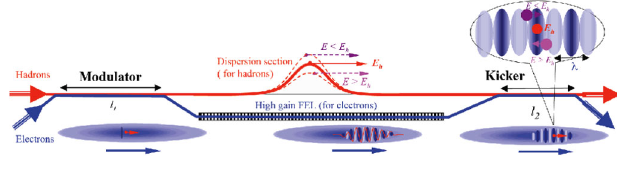
FIG. 1. Schematic of coherent electron